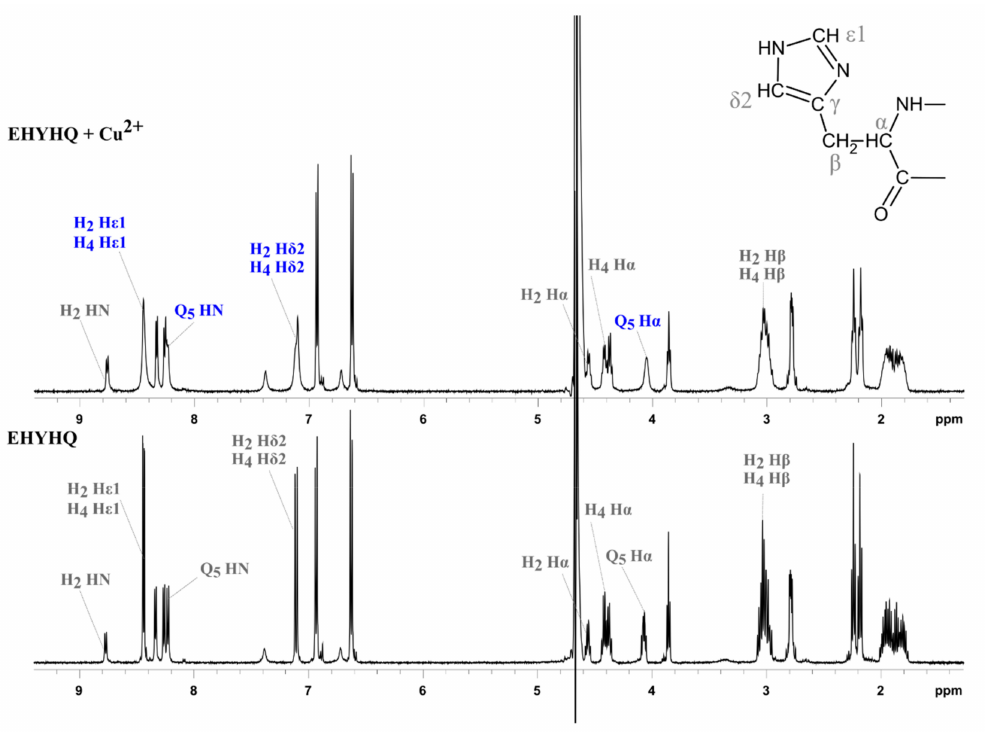
Figure 7. 1 H NMR spectrum of 8 mM EHYHQ in the presence of Cu 2 + ions in 2:1 molar ratio (upper panel) and in the absence of Cu 2 + ions (lower panel) along with selected signals identities: The most significantly broadened signals are marked with